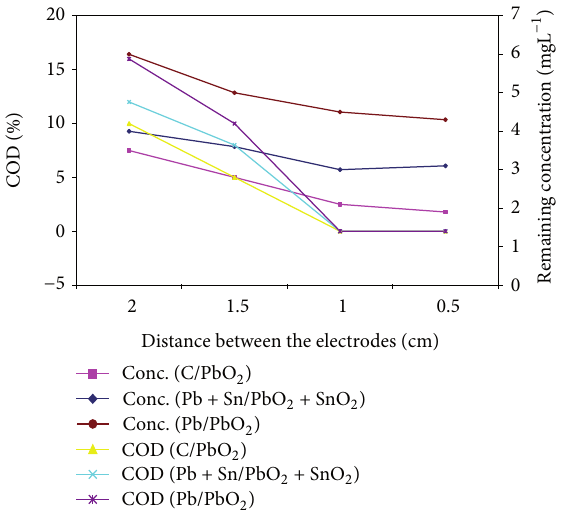
F 7: e effect of distance between the cathode and anode on RY160 and COD removal using